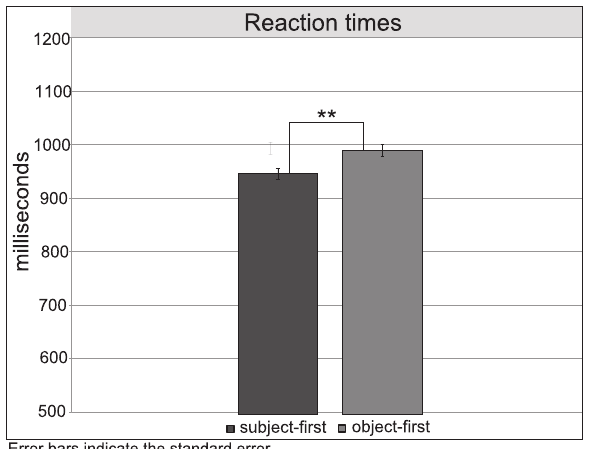
Figure 4. Reaction times for subject-first and object-first sentences in the comprehension